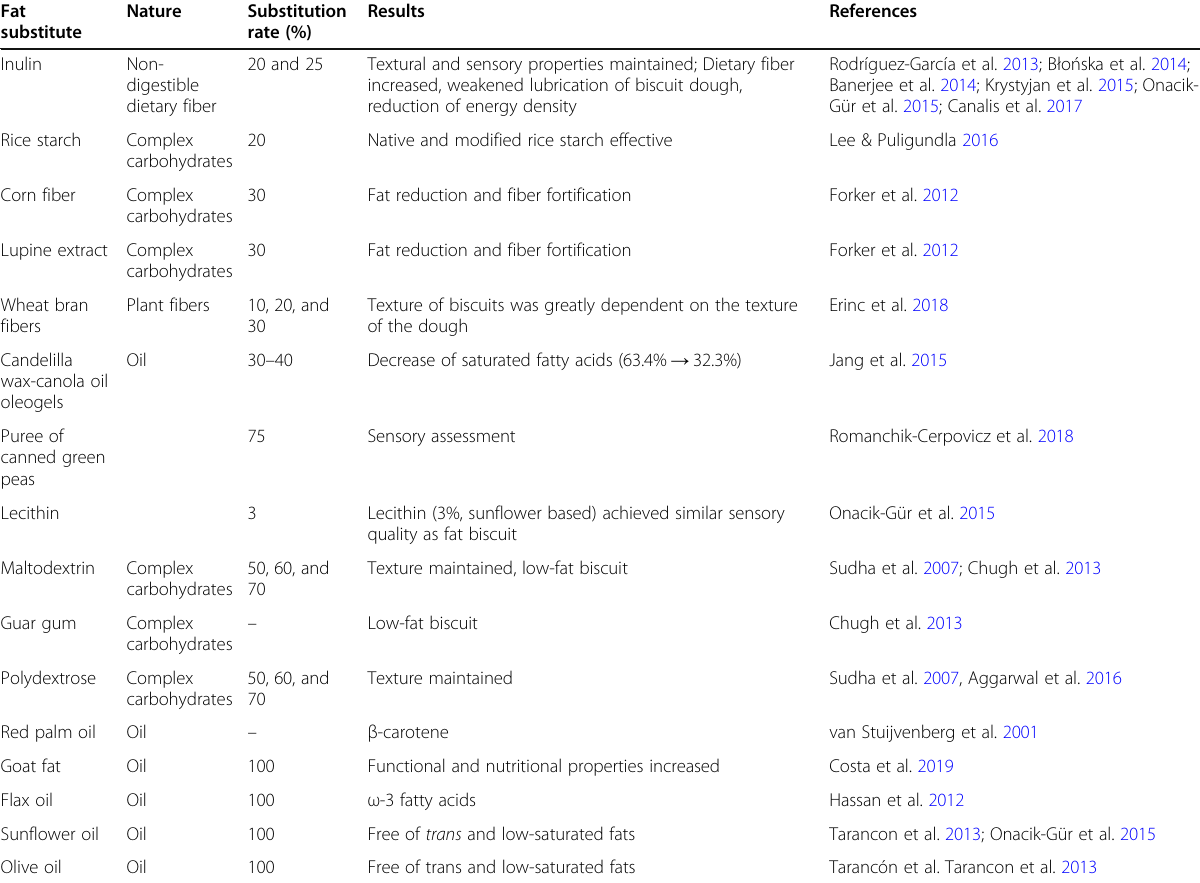
Table 3 Shortening substitutes and their potential effect on biscuit quality